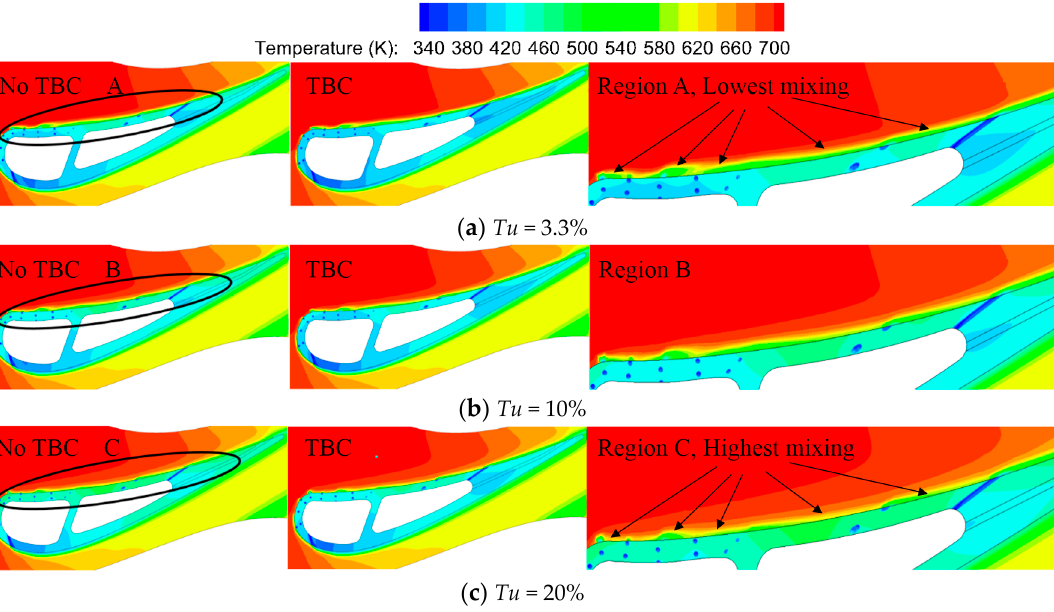
Figure 13. Effect of Tu on cooling air emitted from film holes at midspan.